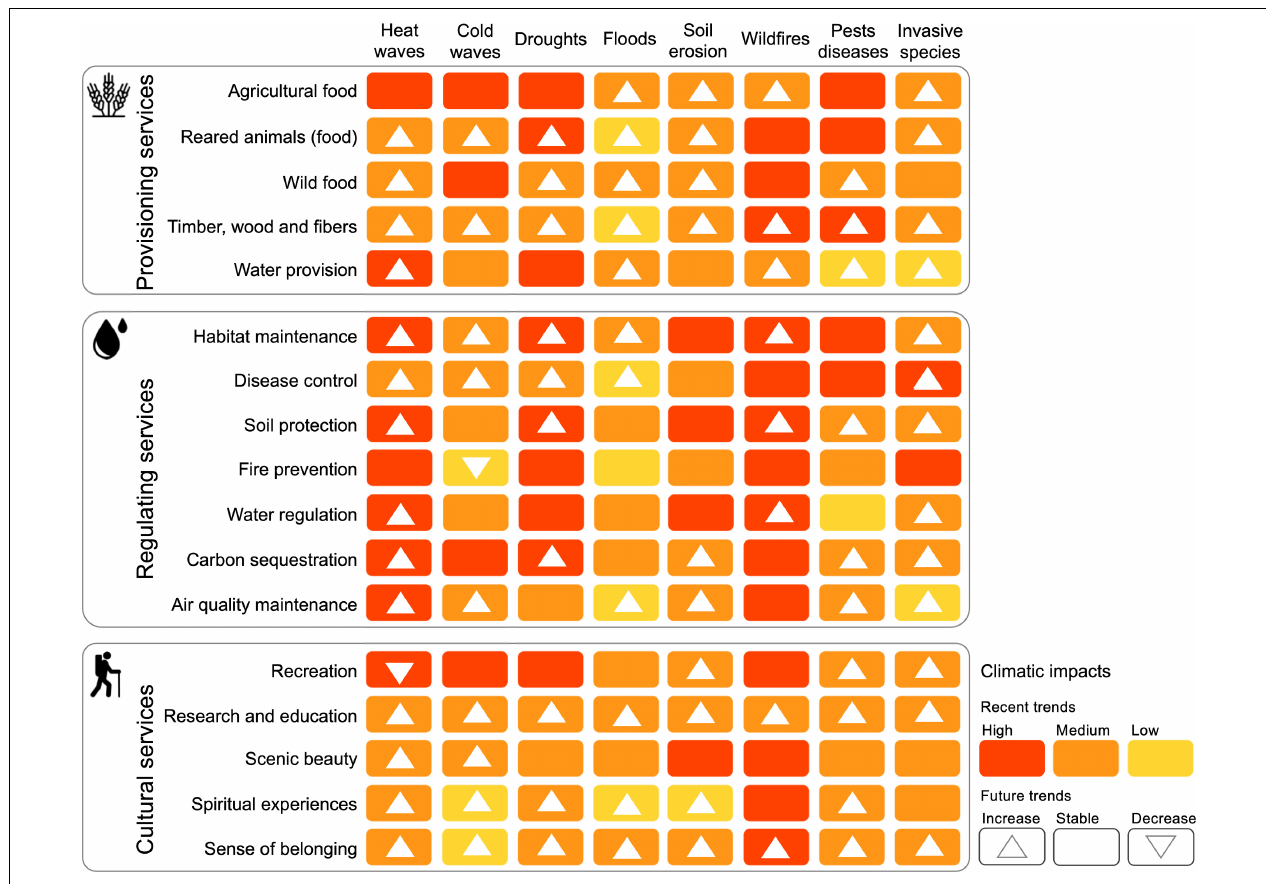
FIGURE 3 | Recent and future impacts of climate change-related drivers on changes in the supply of ecosystem services at the Intermunicipal Community, as indicated by the public officers during the questionnaire-based